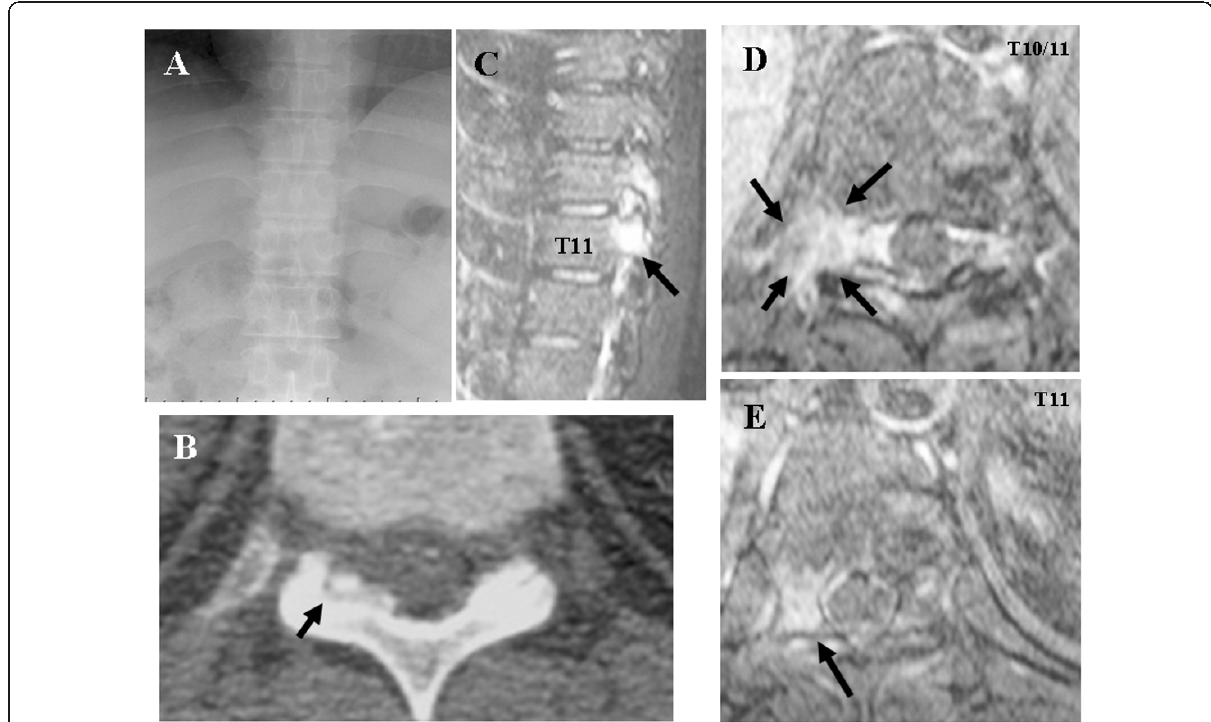
Figure 3 Conventional roentgenogram, CT and Gd-enhanced MR images . A; Anteroposterior radiograph of the thoracic spine revealed no abnormalities. B: CT revealed marked perilesional sclerosis of bone in the right facet. C, D, and E: Gd-enhanced area extended over the intervertebral foramen and the nerve